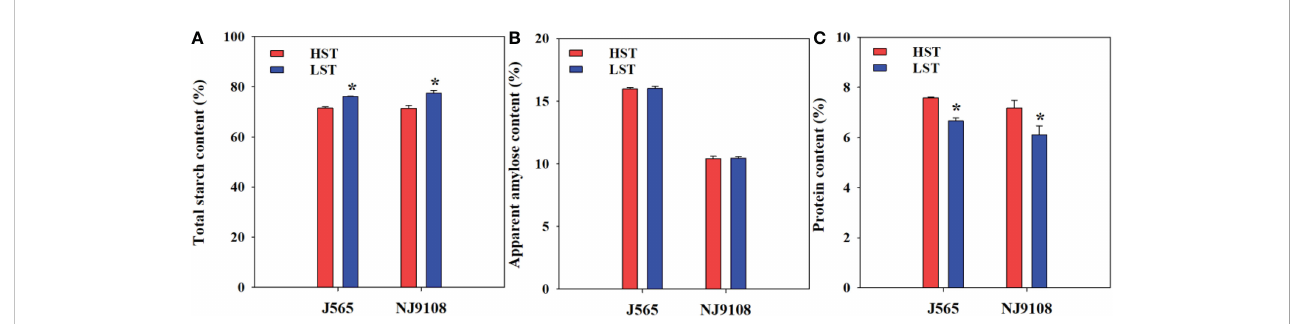
FIGURE 4 Total starch content (A) , apparent amylose content (B) , and protein content (C) in the two growth seasons. HST and LST represent high seasonal temperature and low seasonal temperature, during the reproductive stage in 2017 and 2018. J565 and NJ9108 represent cultivars Jing-565 and Nanjing- 9108. * represents signi fi cant difference between HST and LST at the level of P < 0.05.